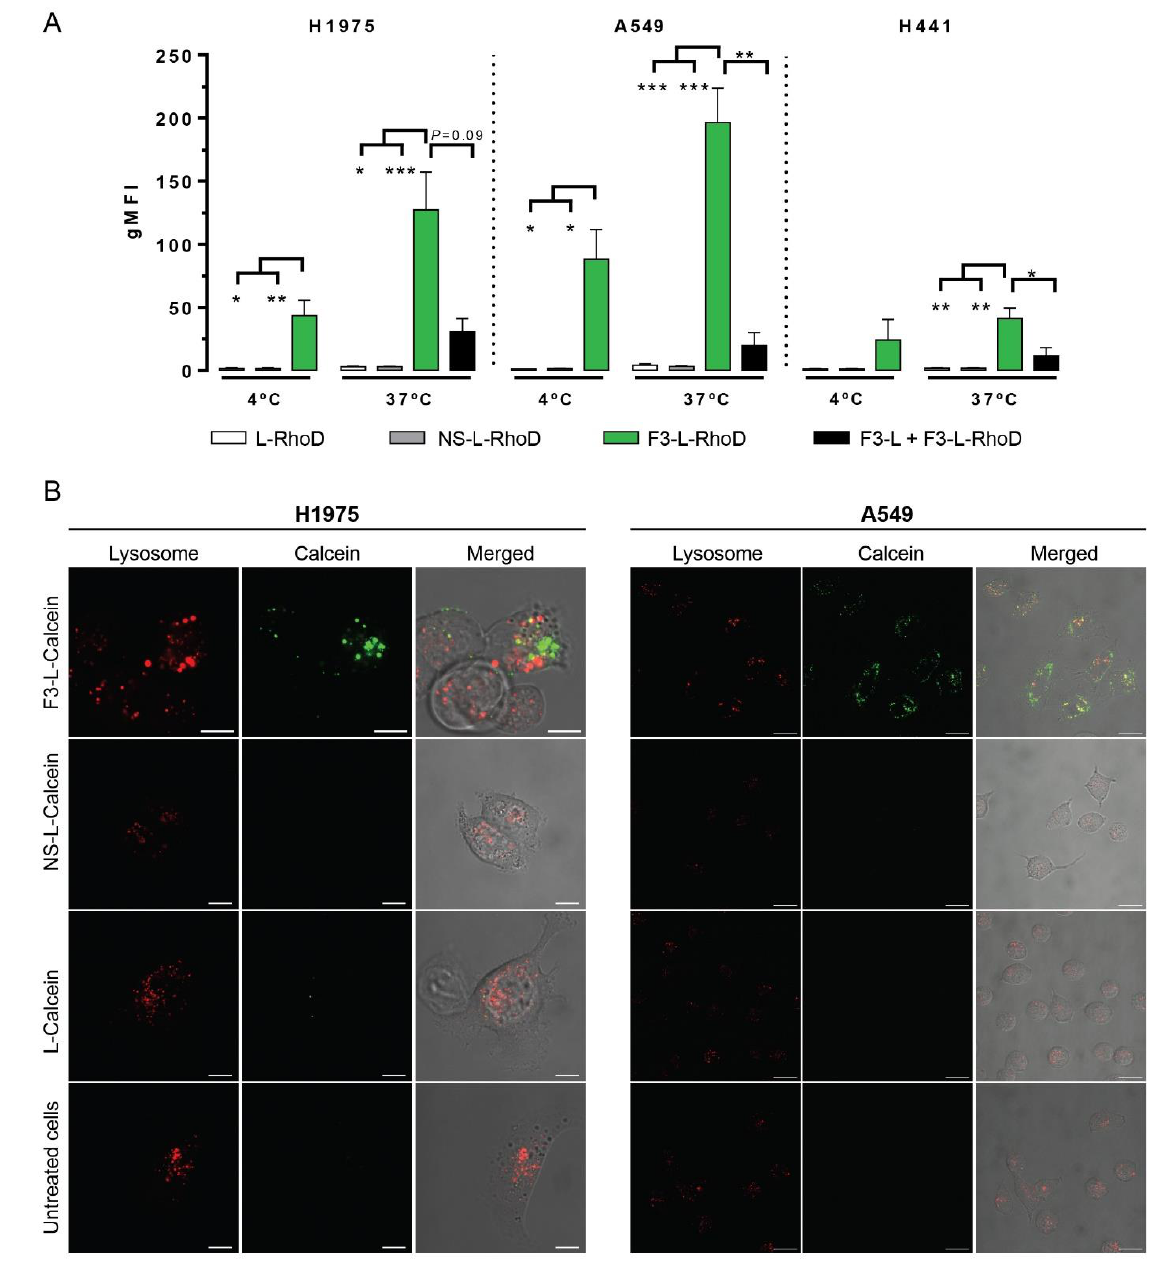
Figure 5. In vitro cellular association and internalization of nucleolin-binding F3-peptide-targeted and non-targeted liposomes by lung cancer cells. H1975, A549, and H441 lung cancer cells were left undisturbed (as control) or incubated at 4 °C (not permissive to internalization) or 37 °C, for 1 h, with rhodamine (Rhod) PE-labelled ( A ) or calcein-labelled (green, B , only at 37 °C) liposomes either non-functionalized (L) or functionalized with nucleolin-binding F3 peptide (F3-L) or non-specific control peptide (NS-L). ( A ) Results were expressed as the geometric mean value of the cell-associ- ated fluorescence intensity (gMFI), normalized to untreated cells ( n = 3–10), as assessed by flow cytometry. gMFIs of liposomal cellular association (F3-L-RhoD, green; NS-L-RhoD, grey; and L- RhoD, white) were represented as mean ± SEM and analyzed as matched data by Friedman test and Dunn’s post hoc test (for H1975) and by 1-way ANOVA and Tukey’s post hoc test (for A549 and H441; * p < 0.05; ** p < 0.01; *** p < 0.001); competitive inhibition study upon pre-incubation with F3- L (black) was compared to F3-L-RhoD, without pre-incubation (green), using paired t -test (* p < 0.05; ** p < 0.01). ( B ) Colocalization of calcein-labelled (green, aqueous core) liposomes (F3-L-Calcein, NS-